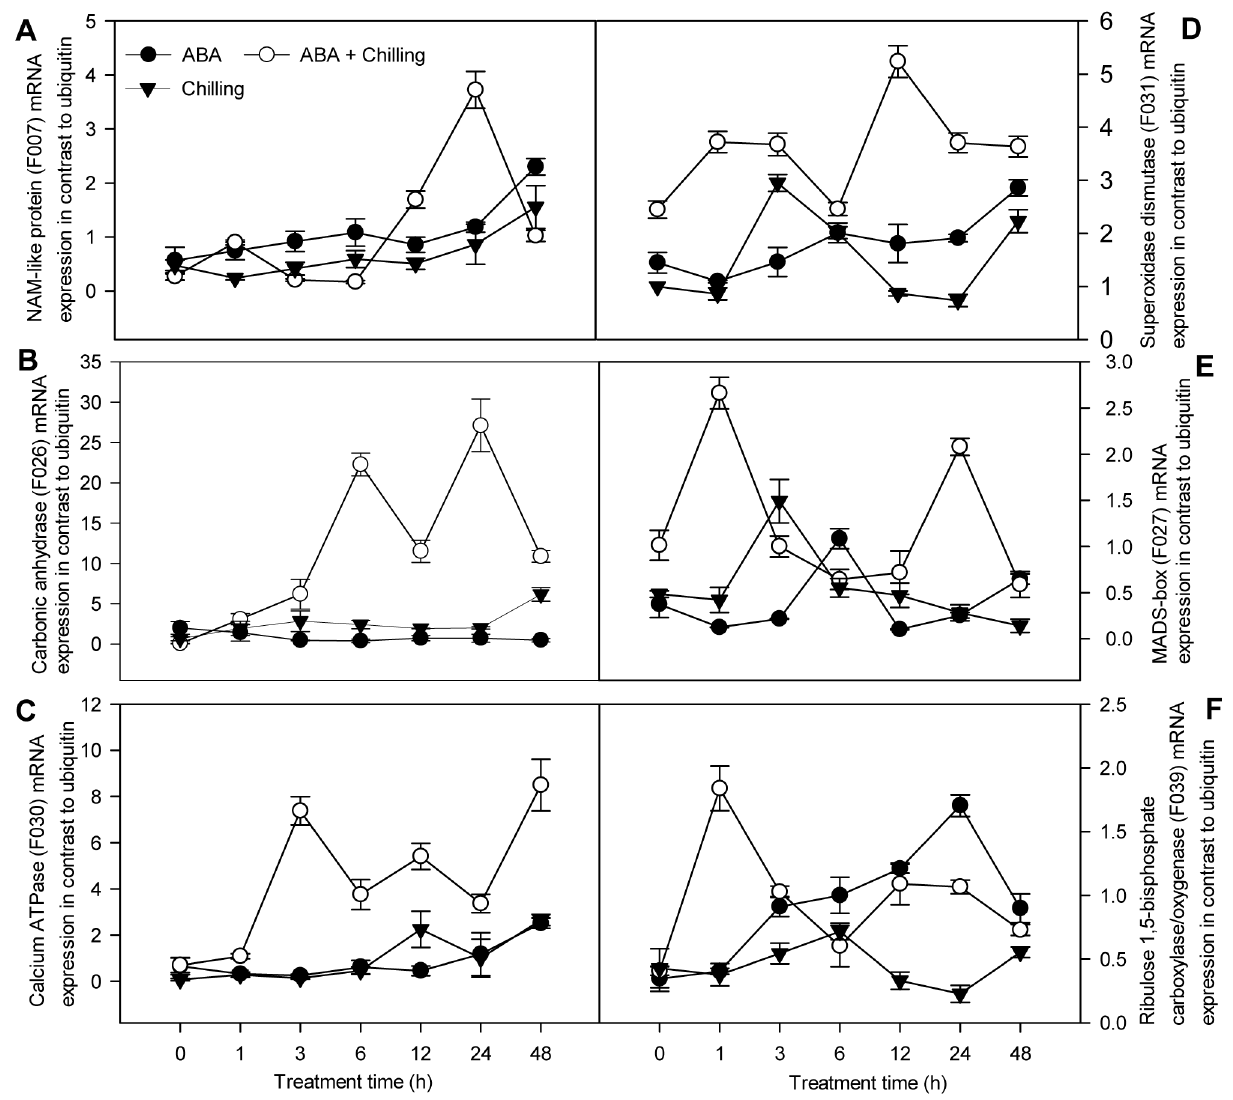
Figure 4. Analysis of mRNA expression of six genes using qPCR found upregulated with SSH. Total RNA was extracted from pepper leaves with ABA spray or water, subsequently 72 h after foliar application exposed for 48 h to 6 u C. SE was calculated based on three biological replicates. Closed circle: ABA-pretreated samples under room temperature; open circle: ABA-sprayed samples prior to chilling stress; triangle down: water-sprayed samples prior to chilling stress. Reaction conditions for each gene are shown in ‘Materials and methods’. The level of ubiquitin was used as an internal reference gene.